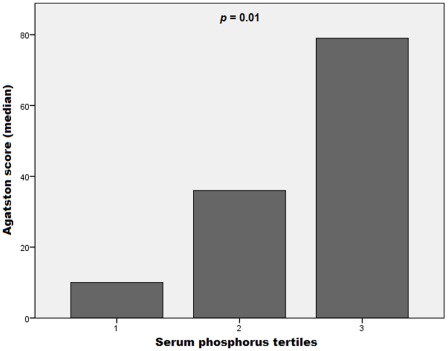
Agatston scores by serum phosphorus tertiles.Results are expressed as medians. Agatston scores were progressively higher across phosphorus tertiles (P = 0.01).